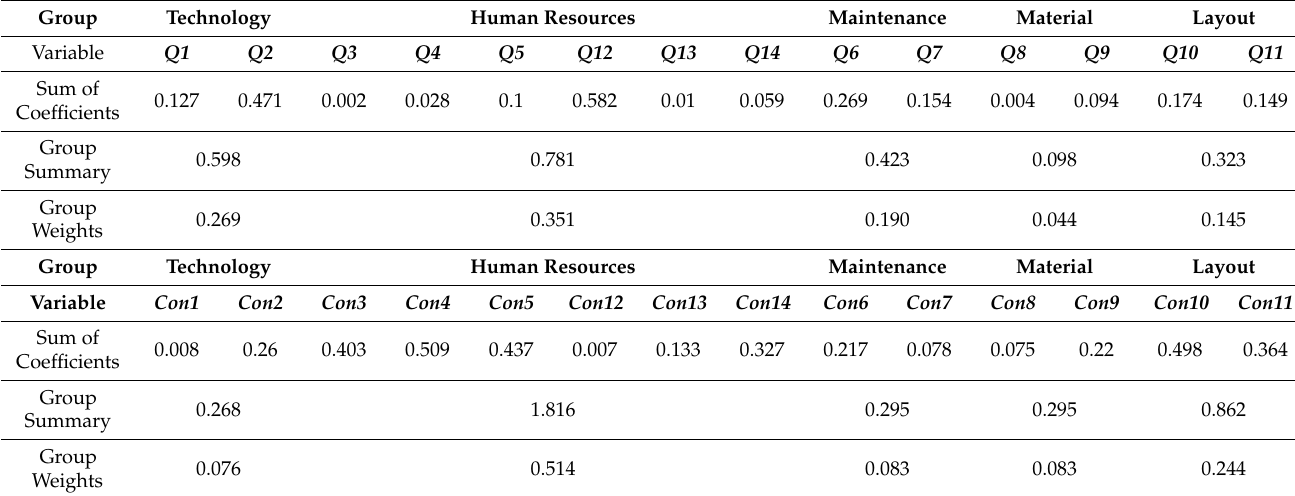
Table 8. Crisp weights of the group factors and confidence.